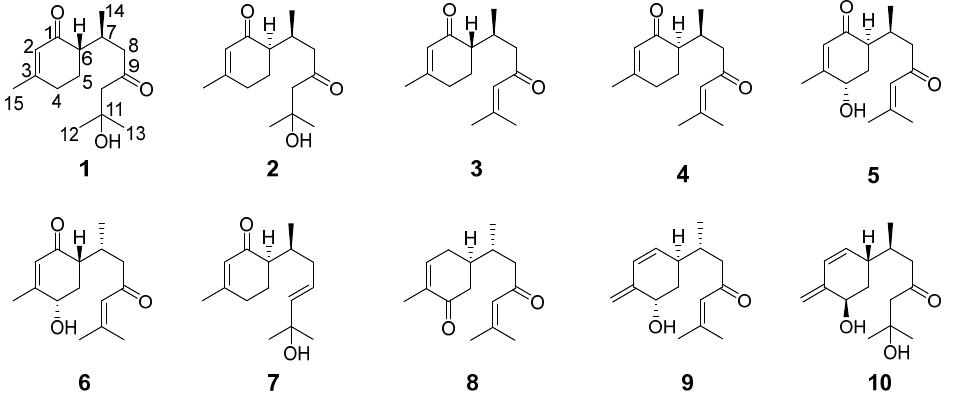
Figure 1. Chemical structures of compounds 1 –